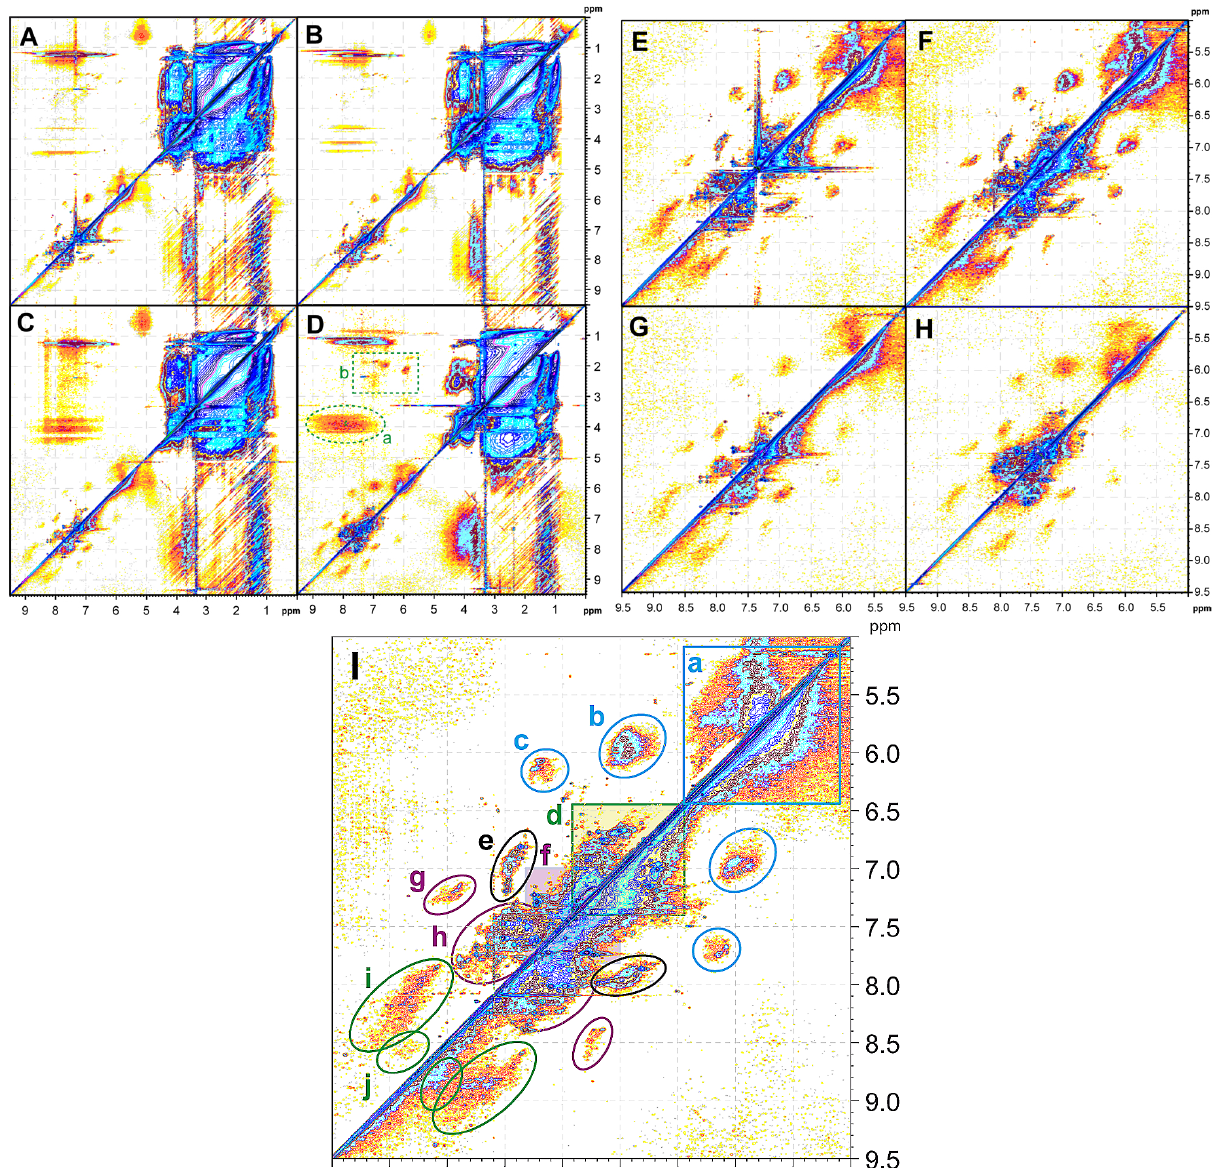
Fig. 12. TOCSY NMR cross peaks of four marine SPE-DOM ( (A, E) : 5m (near-surface photic zone); (B, F) 48m (fluorescence maximum); (C, G) 200m (upper mesopelagic zone); (D, H) 5446m (30m above seafloor)) with sensitivity enhanced apodization to emphasize less abundant sp 2 -hybridized carbon environments in marine SPE-DOM. (A–D) full spectrum δ H = 0–9.5ppm; (E–H) section of unsaturated (olefinic and aromatic) protons δ H = 5–9.5ppm; (D) dotted box a: TOCSY cross peaks connecting peptides H N-C H α ; dotted box b: TOCSY cross peaks connecting olefins and methyl, C= H C-C H 3 . (I) unsaturated (olefinic and aromatic) protons in surface SPE-DOM 48m with sub- structures denoted as follows: section a: intra-olefinic cross peaks H C olefin = C olefin H , like in linear terpenoids; section b: α , β -unsaturated double bonds: H C olefin = C olefin H -(C=O)-X; section c: polarized α , β -unsaturated double bonds: H C olefin = C olefin H -(C=O)-X; section d: aromatics H C aromatic -C aromatic H with ortho and/or para oxygenated substituents (classic aromatic substitution of natural organic matter); section e: strongly polarized α , β -unsaturated double bonds, also in oxygen-derived heterocycles: H C olefin -C olefin H -(C=O, O)-X; section f: condensed and strongly electron withdrawing aromatics H C aromatic -C aromatic H (multiply carboxylated, N-heterocycles); section g: poly- cyclic aromatics, open fjord region (cf. Fig. 11a sections B1, B2), N-heterocycles; section h: polycyclic aromatics, fjord region in polycyclic aromatics, more extended polycyclic aromatics, N-heterocycles; section i: congested fjord region in polycyclic aromatics (cf. Fig. 11a sec- tions A1, A2, A3); and section j: alike section i, and H C -C H in condensed polycyclic sp 2 sp 2